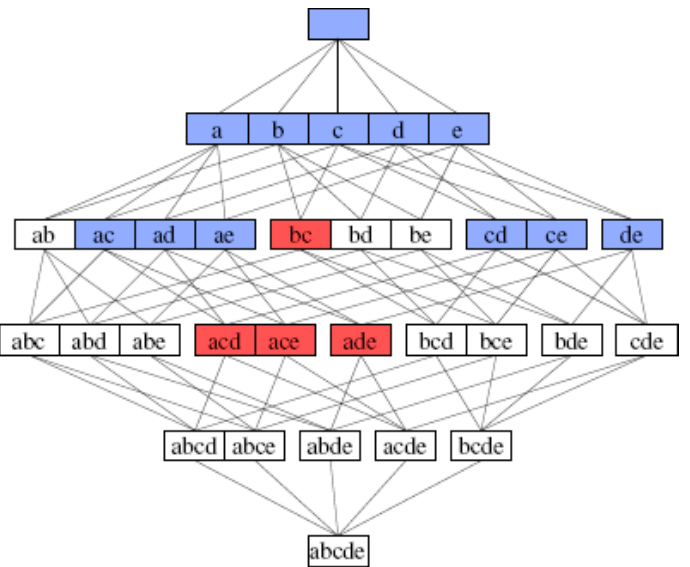
Figure 3. Pattern Mining Available online: https://borgelt.net/teach/fpm/ (accessed on 5 April 2022).